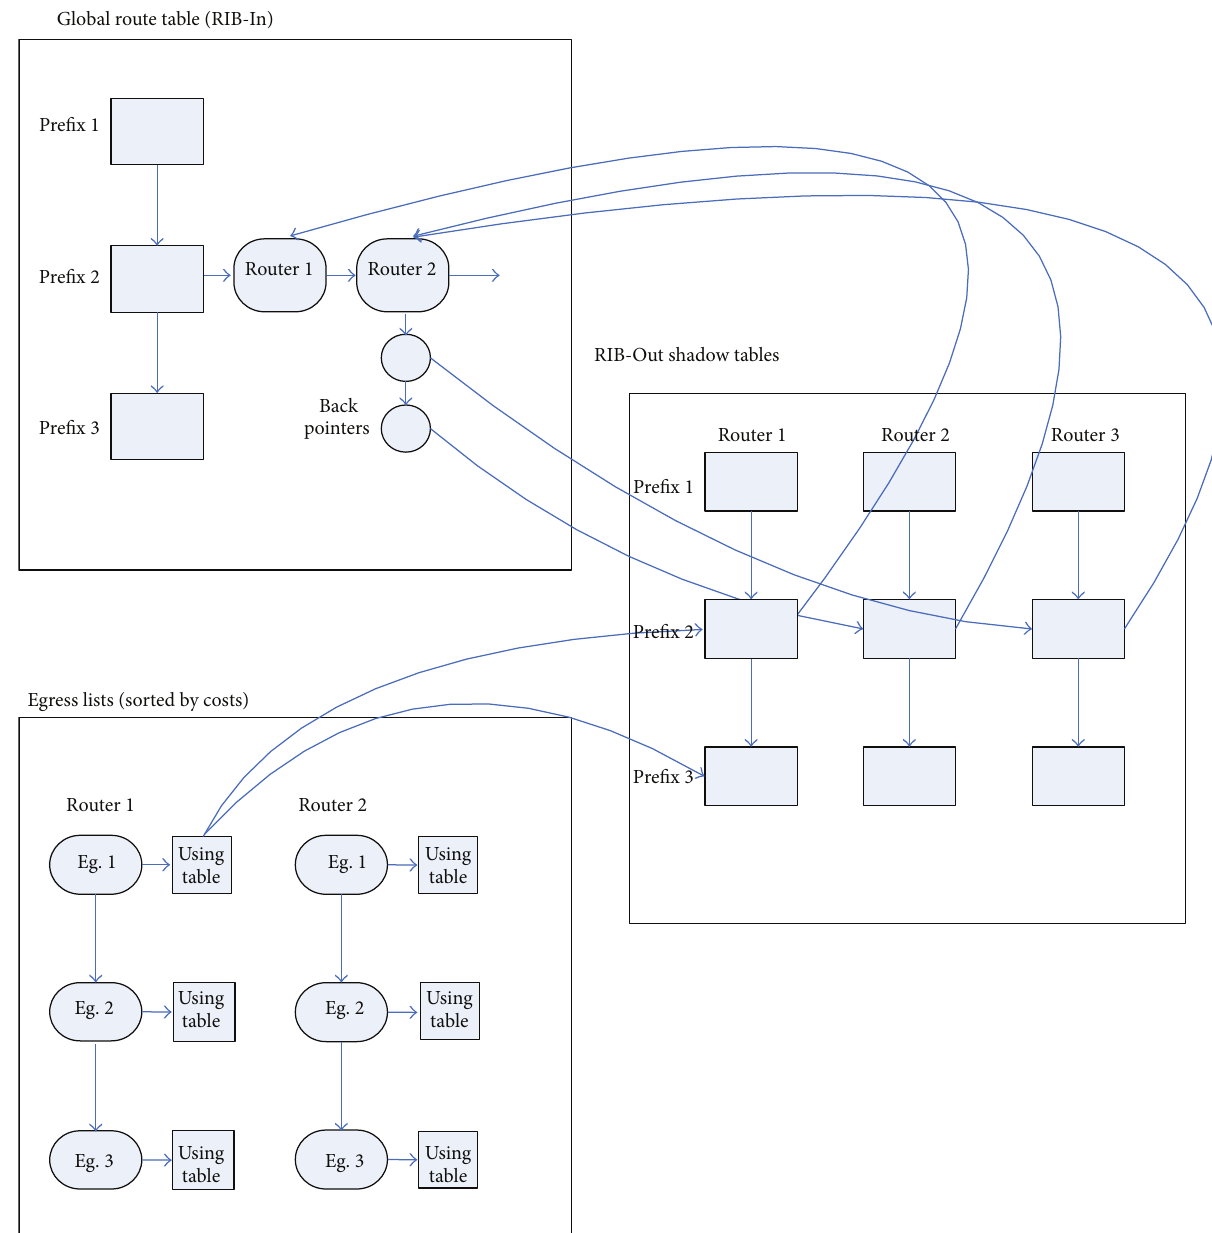
Figure 5: Data structures of RIB-Out and RIB-In route table and egress lists of root